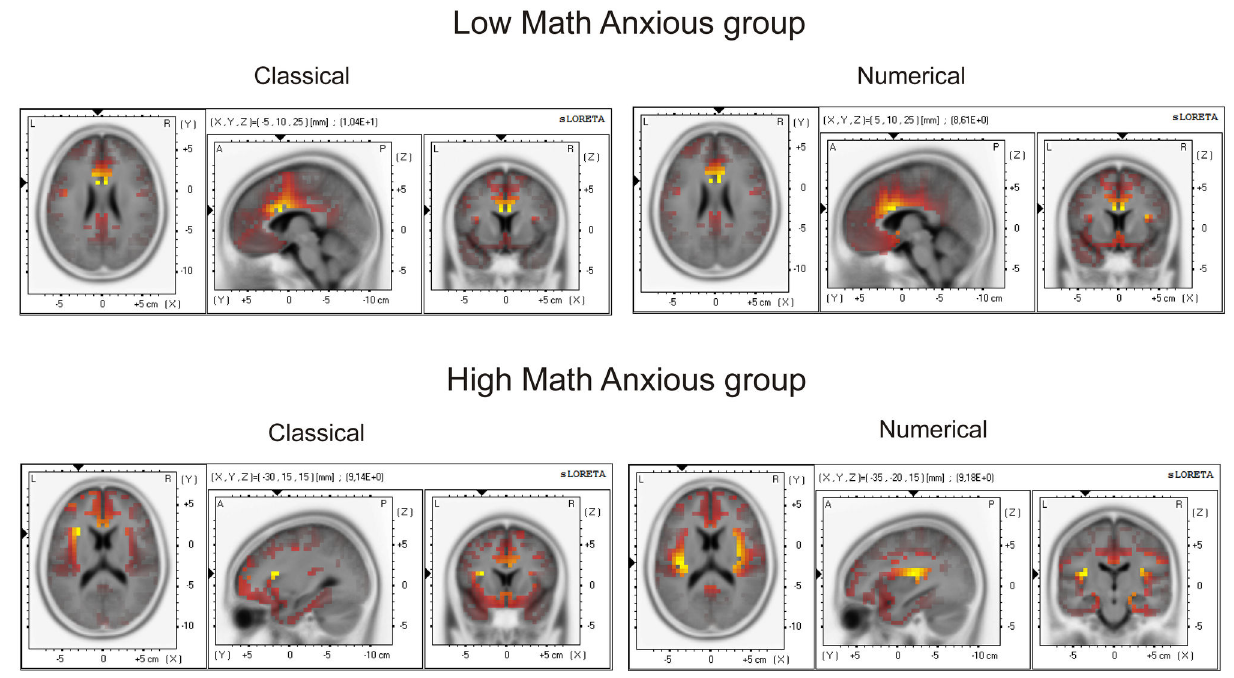
Figure 6. Images of neural activity computed with sLORETA. The images represent cortical areas showing significant activation (p < .01) for the ERN as compared to the CRN in the 50-90 ms window for the LMA and the HMA groups in the numerical and the classical Stroop